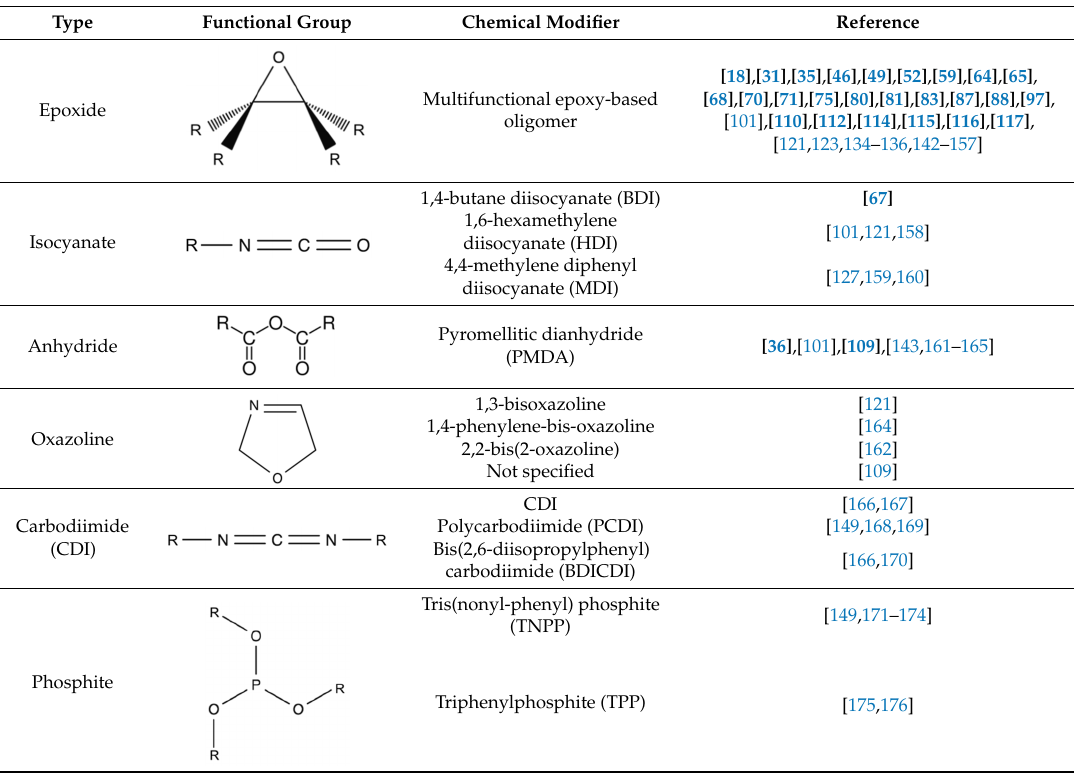
Table 2. Overview of commonly used chain extenders (CEs) from the literature used for PLA melt modification sorted by their functional groups (Please note: references for foams from chemically modified PLA are marked in bold ).